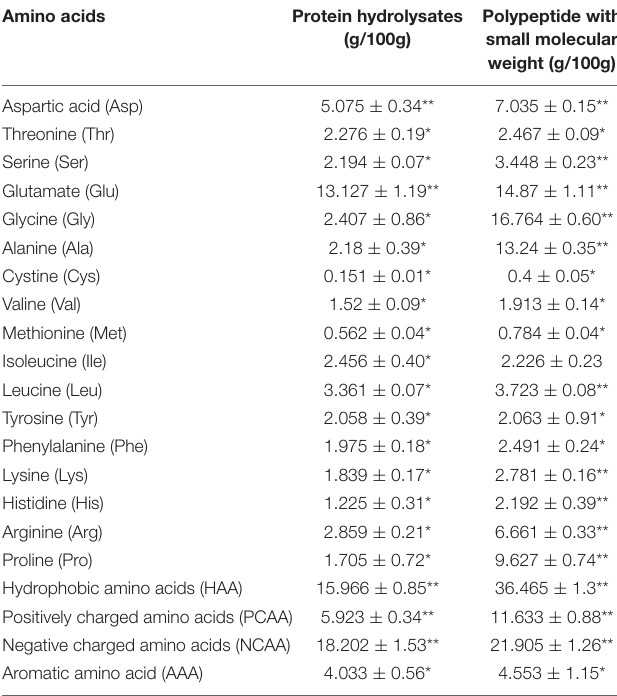
TABLE 1 | Amino acid analysis of protein hydrolysates and polypeptide with a small molecular weight. Amino acids Protein hydrolysates